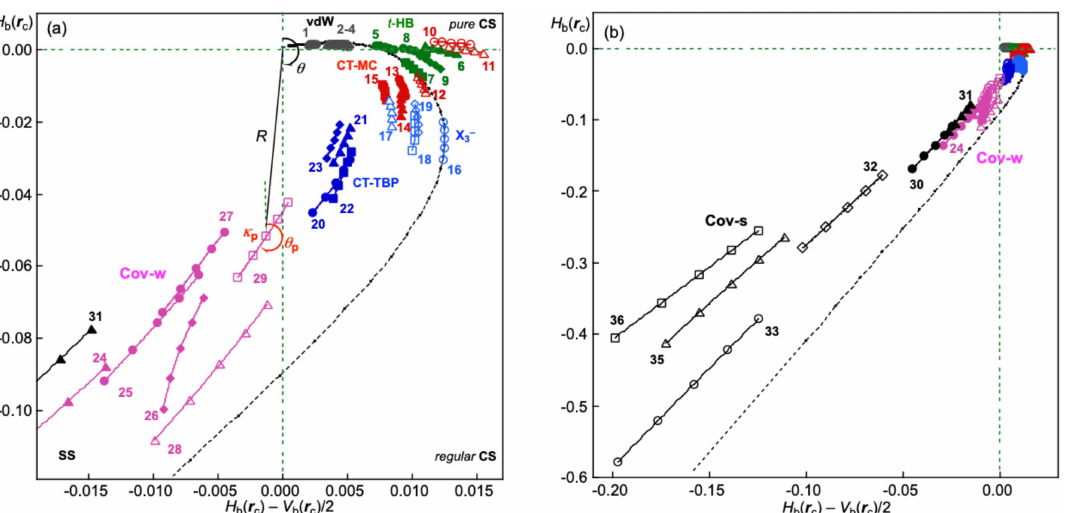
Figure 1. QTAIM-DFA plots of H b ( r c ) versus H b ( r c ) − V b ( r c )/2 for CS of vdW, HB, CT-MC, X 3– , and CT-TBP ( 1 – 23 ); SS of Cov-w ( 24 – 29 ) ( a ) and SS of Cov-w and Cov-s ( 30 – 36 ) ( b ), where the perturbed structures are generated with CIV under MP2/BSS-A. The dotted lines in ( a ) and ( b ) correspond to the plot of the wide range of the data for [Cl–Cl- ∗ -Cl] − ( 16 ). The numbers and colors in the figure are the same as the numbers and colors in Scheme